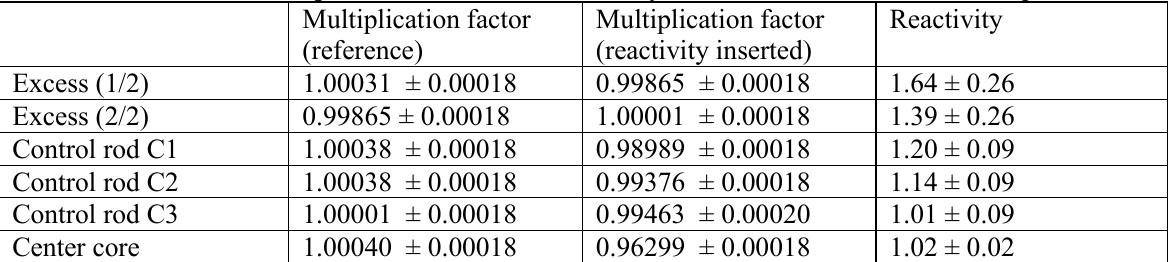
Table V. C/E value of multiplication factor and reactivity with ENDF/B7.0: Errors correspond to 2σ